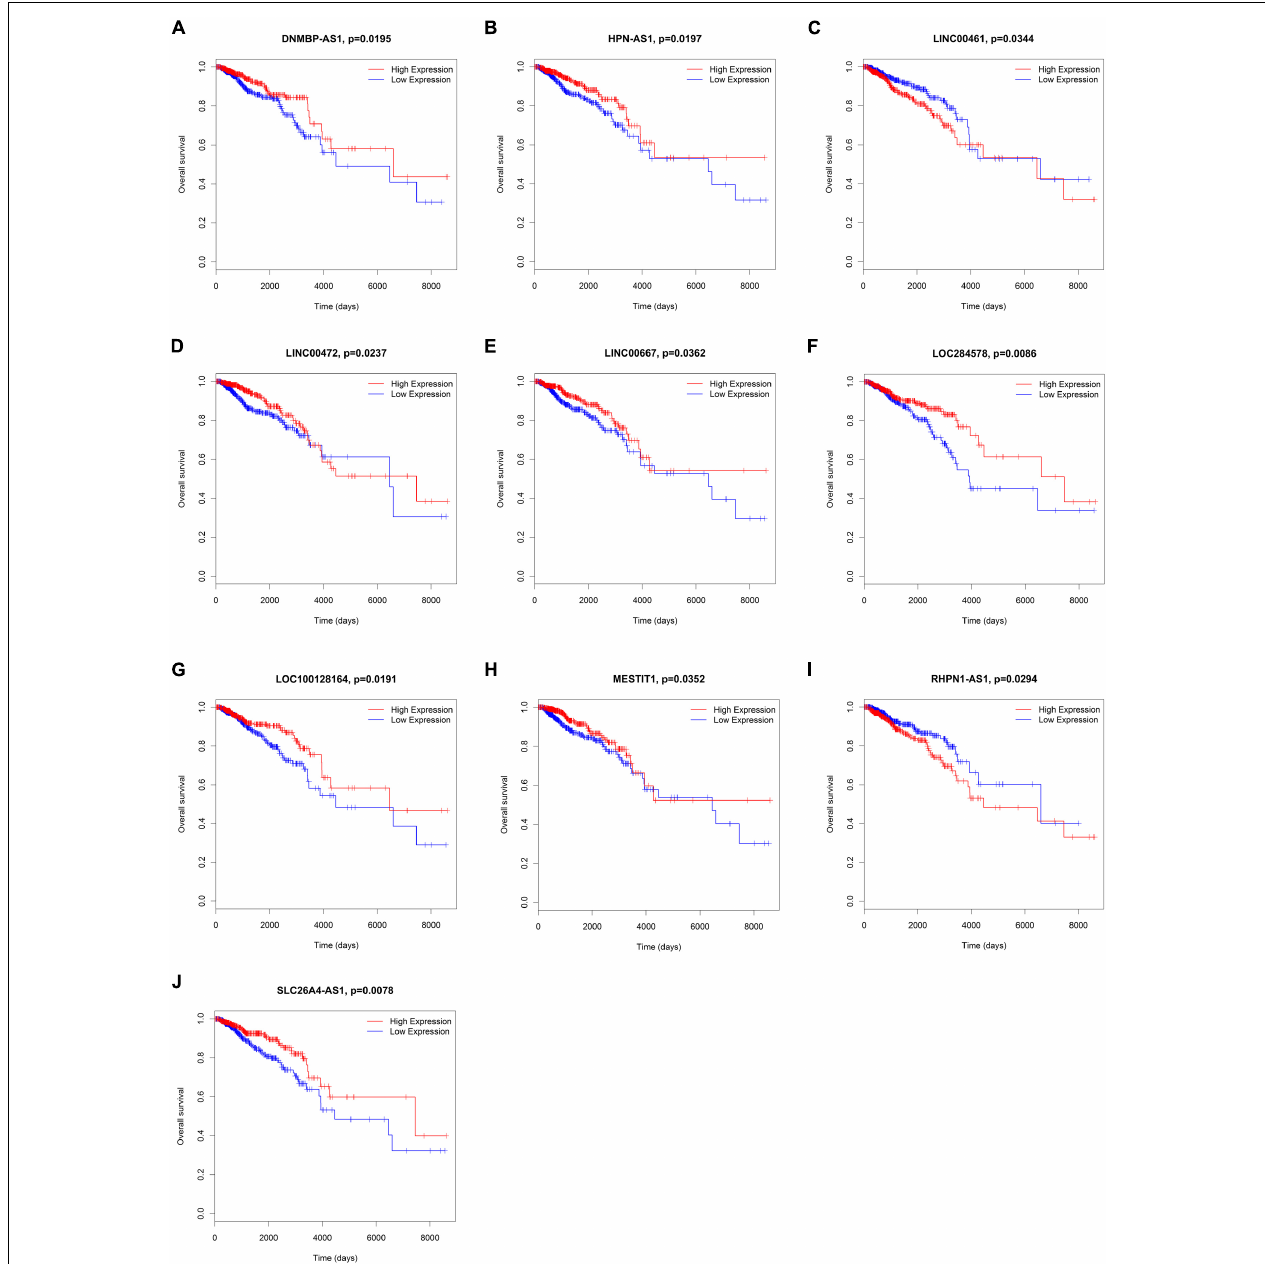
FIGURE 6 | Kaplan–Meier survival curves for 10 lncRNAs associated with overall survival. (A) DNMBP-AS1. (B) HPN-AS1. (C) LINC00461. (D) LINC00472. (E) LINC00667. (F) LOC284578. (G) LOC100128164. (H) MESTIT1. (I) RHPN1-AS1. (J)